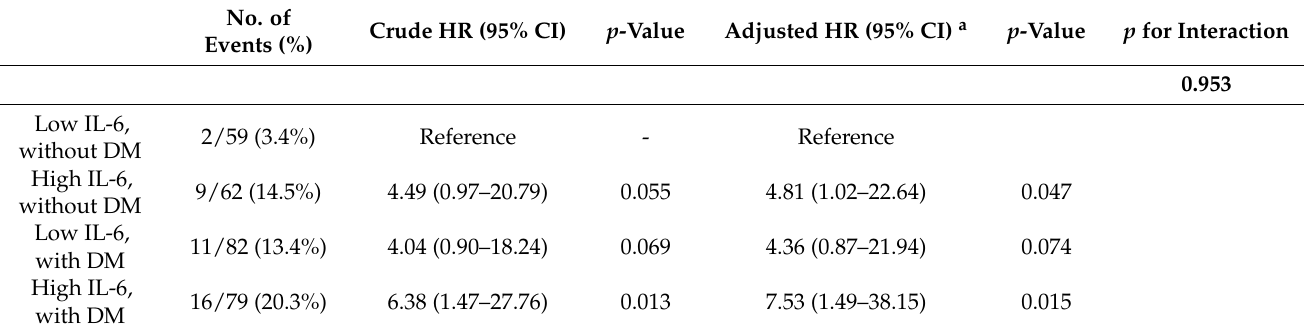
Table 4. Hazard ratios of plasma IL-6 levels for the arteriovenous fistula dysfunction according to predefined subgroups.